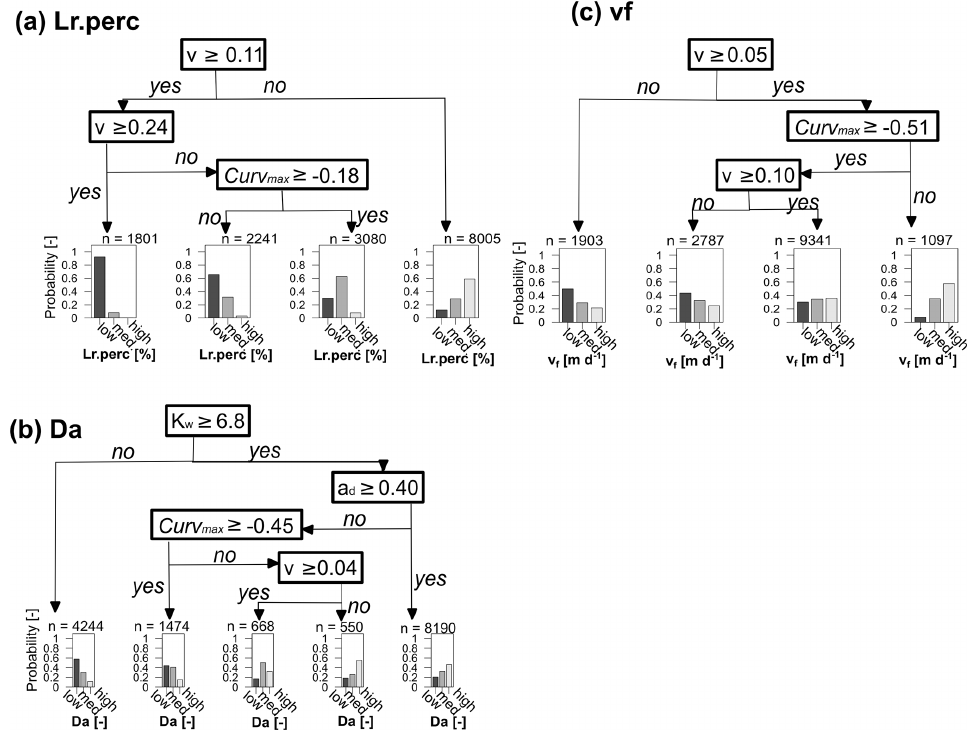
Figure 7. CART decision trees for the response variables L r.perc (accuracy = 0.66), Da (accuracy = 0.51) and v f (accuracy = 0.40). The trees are read from top to bottom, where the binary splits are followed to arrive at a histogram, illustrating the probability of a test sample having low, medium or high values (Table 3) for a certain response variable. The variables at the binary splits differ per response variable and consist of the median stream velocity ( v ; md − 1 ) and Curv max for response variables L r.perc and v f , while width coefficient K w and depth exponent a d are identified additionally for Da. The prediction metrics for each of these classes and response variables are stated in Table